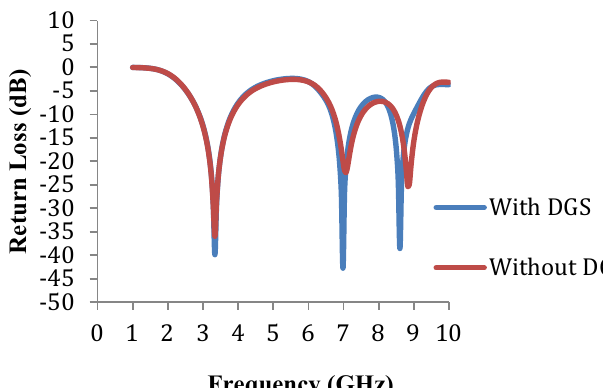
Figure 13: Return loss comparison of antenna with DGS and without